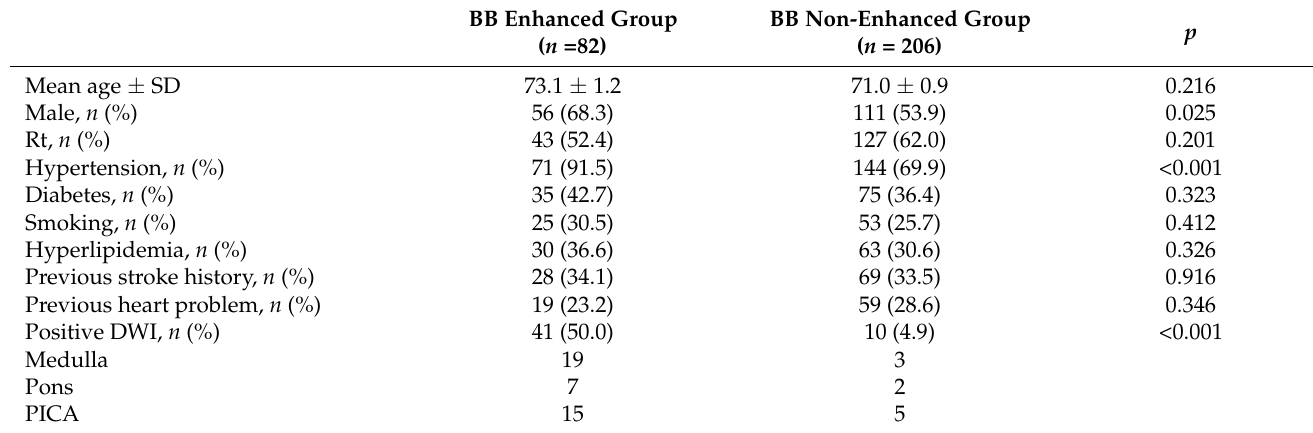
Table 2. Comparison of two groups with enhanced VA or non-enhanced VA on BB MR imaging.